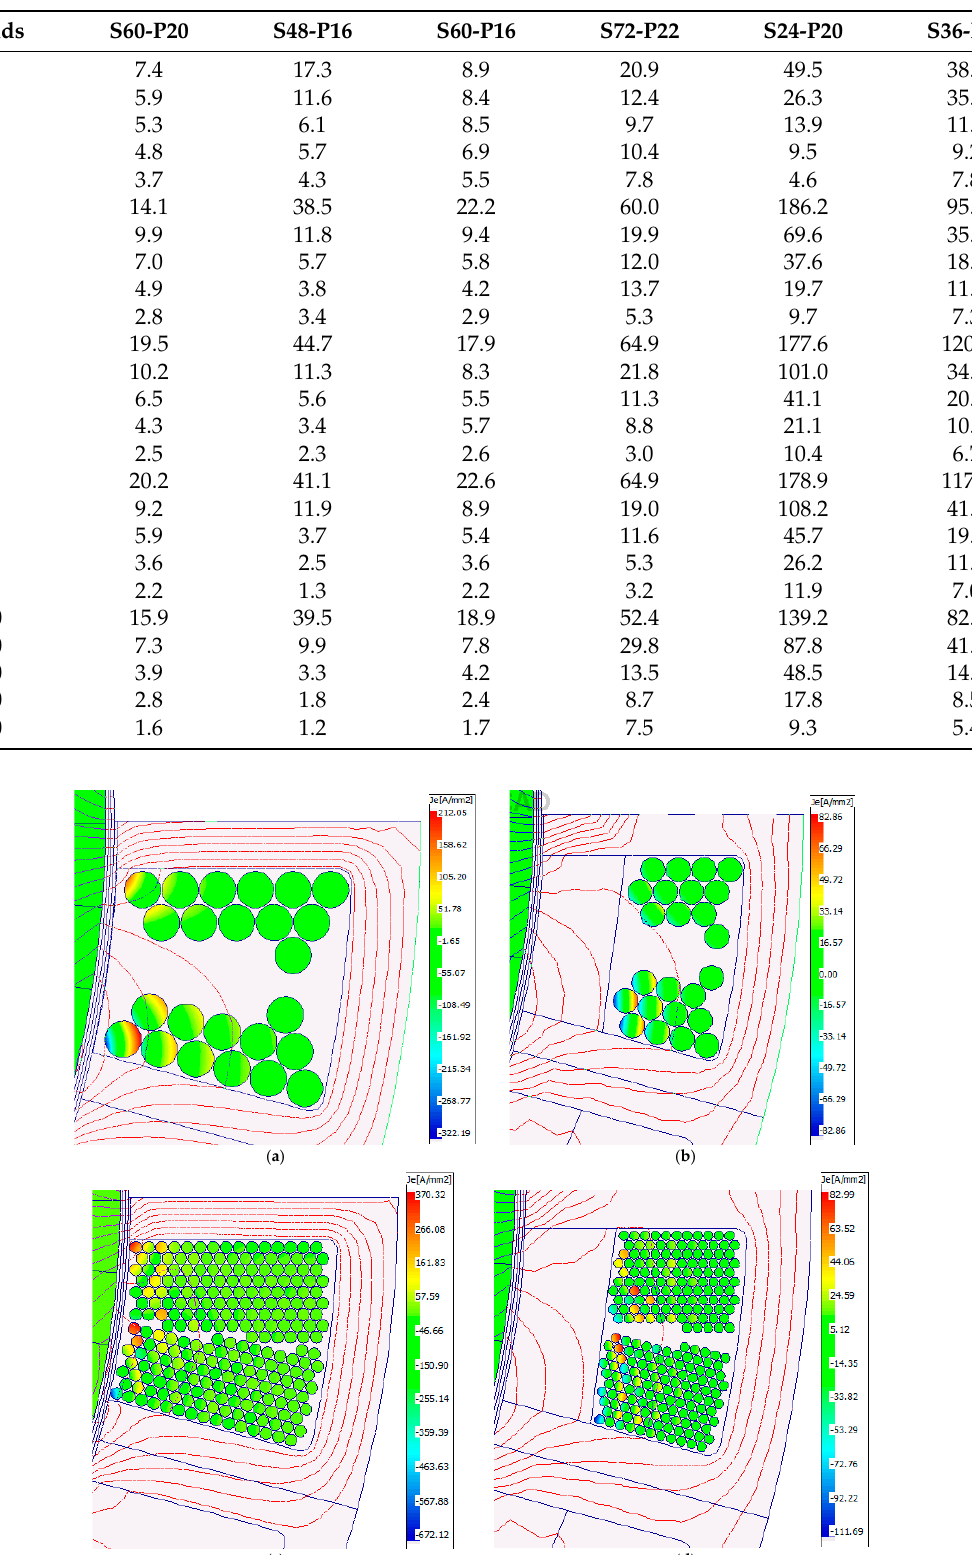
Table 4. AC losses (kW) for the stranding losses.